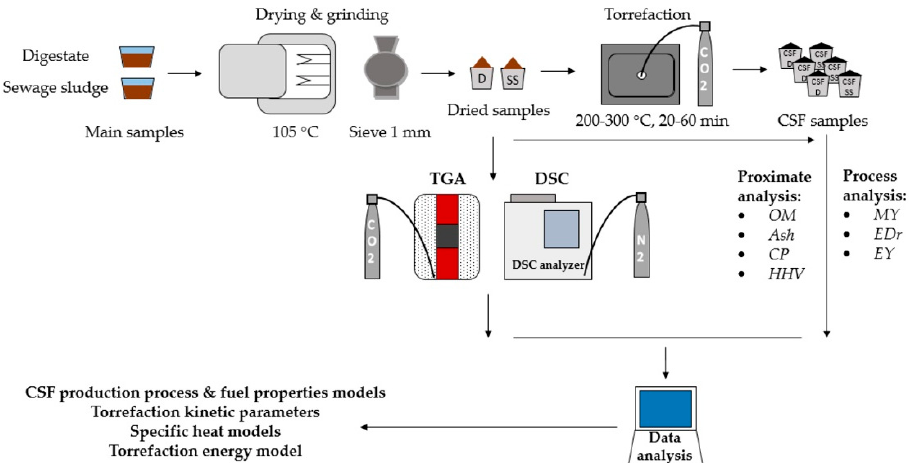
Figure 1. Experiment setup to convert sewage sludge and digestate to carbonized solid fuel (CSF) via torrefaction. The resulting CSF was analyzed for inputs to techno-economic analyses. D = biogas plant digestate; SS = sewage sludge. TGA = thermogravimetric analyses. DSC = differential scanning calorimeter analysis; OM = organic matter; CP = combustible parts; HHV = high heating value; MY = mass yield; EDr = energy densification ratio; and EY = energy yield.